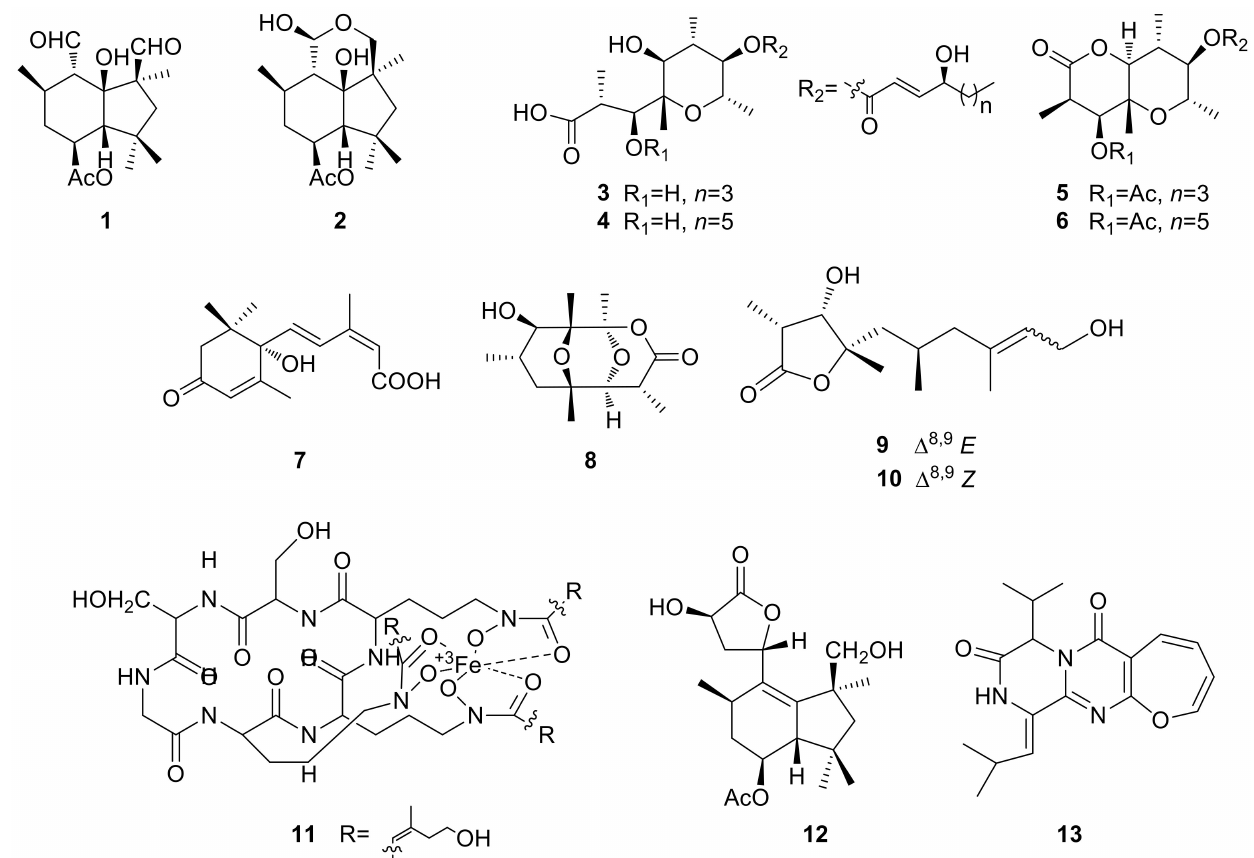
Figure 1. Some of the metabolites isolated from B. cinerea